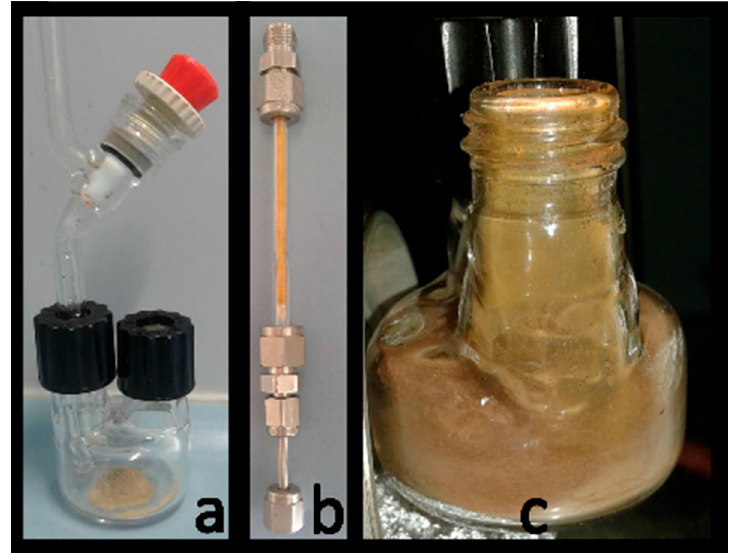
Figure 8. Reactors used for running the photochemical reaction. ( a ) Bulk nano-sized catalyst in a batch-reactor. ( b ) Flow-reactor loaded with bulk nano-catalyst. ( c ) Nano-sized catalyst finely dispersed on the wall of the reactor, simulating a nano-film.